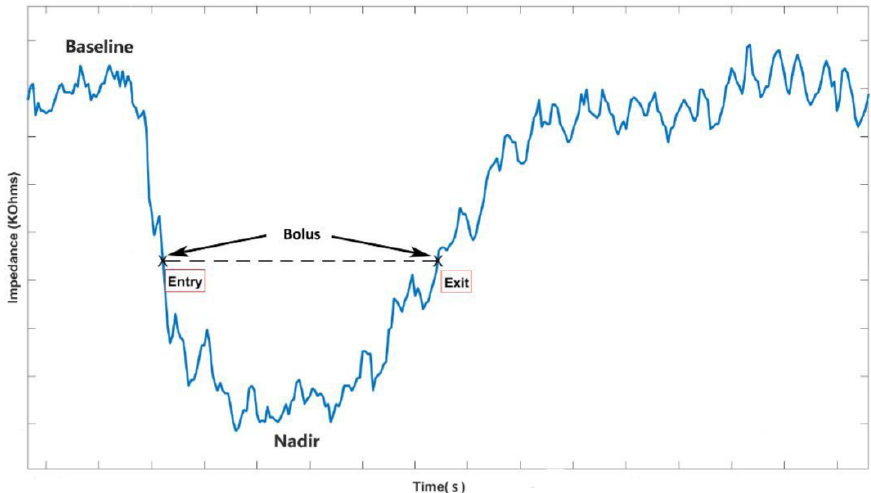
Figure 2. Successful bolus transmission through one impedance channel in the esophagus. Impedance changes observed during bolus transmission between a single pair of measurement rings separated by 2 cm. The impedance signal dropped when the fluid bolus material passed the impedance-measuring segment. Bolus entry occurred when impedance dropped by 50% from baseline relative to nadir, and bolus exit occurred when it recovered by 50% from nadir to baseline. The black dotted lines indicated the bolus from entry to exit. (2) Successful bolus transmission through the LES into the stomach